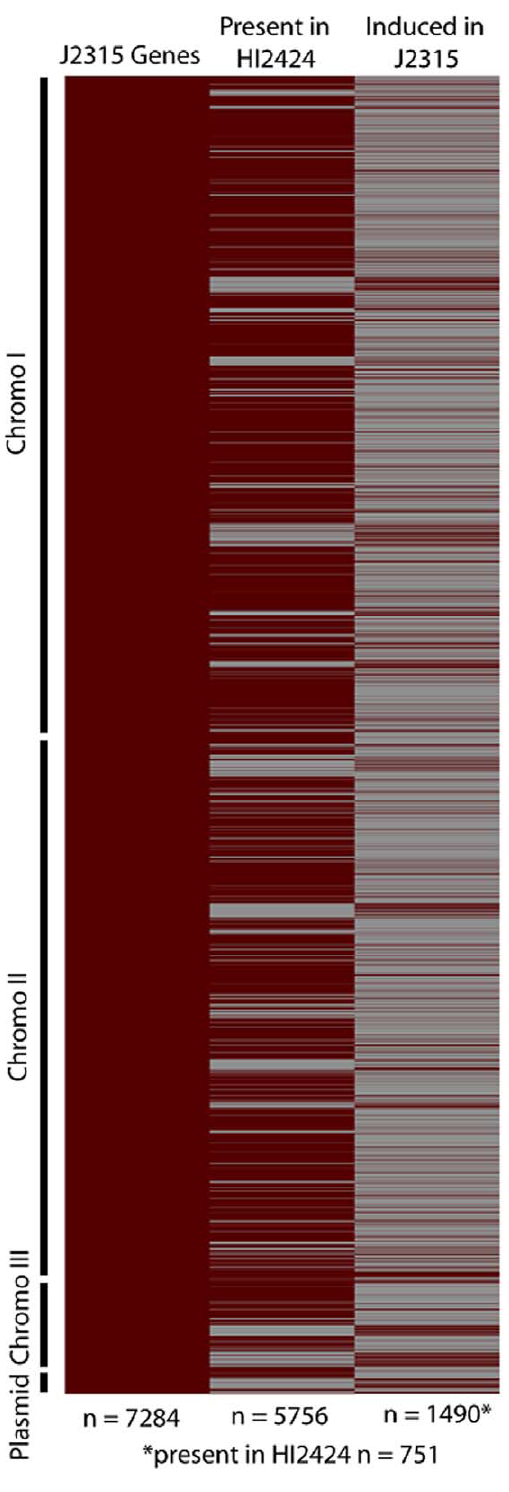
Figure 4. Distribution of J2315 genes, HI2424 homologous genes, and genes induced in J2315 compared to HI2424. Heat map analysis reveals gene clusters induced in J2315 compared to HI2424 under CF conditions that are shared (shown in the middle lane) or unique to J2315. Open reading frames in HI2424 bearing at least 70% identity over 70% of the length were considered homologous to J2315 genes. Red color indicates present/induced and gray indicates absent/ not